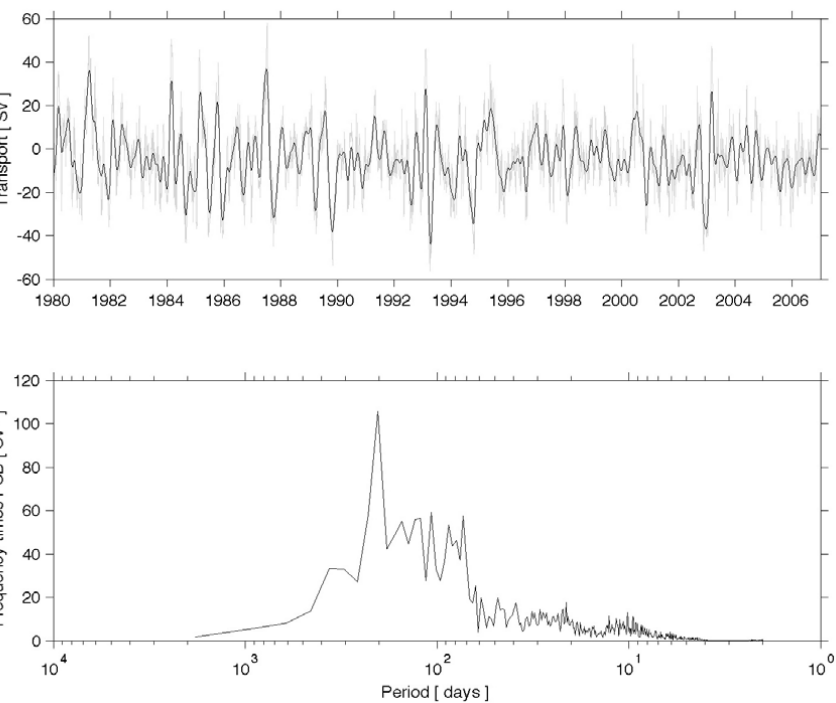
Fig. 9. Upper panel: DWBC transport from the OFES model integrated over the same span as the real observations. Gray line is the 3-day Figure 9: Upper panel: DWBC transport from the OFES model integrated over the same subsampled model output, while the black line is the 90-day low-pass filtered record. Lower panel: spectra of the DWBC transport from span as the real observations. Gray line is the 3-day subsampled model output, while the OFES (using the 3-day subsampled, unfiltered black line is the 90-day low-pass filtered record. Lower panel: Spectra of the DWBC transport from OFES (using the 3-day subsampled, unfiltered data).